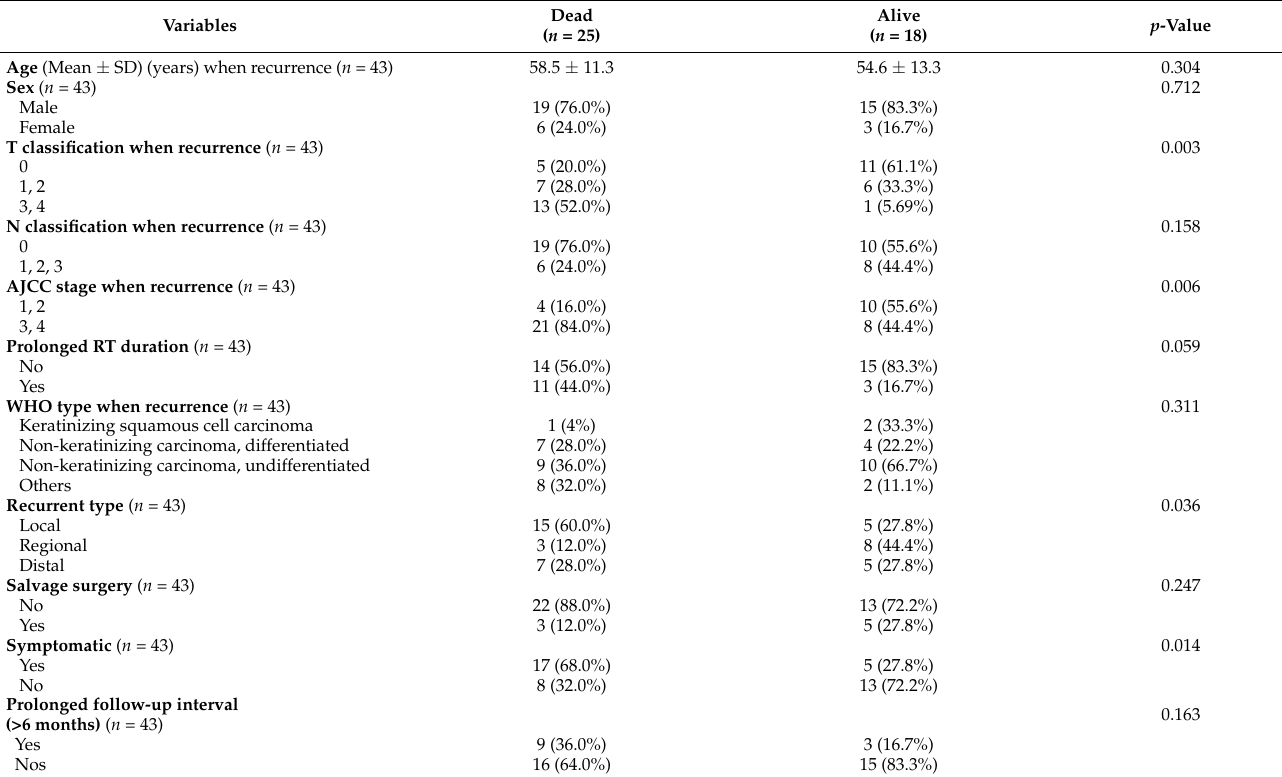
Table 5. Demographic data of long-latent recurrent group (alive vs.